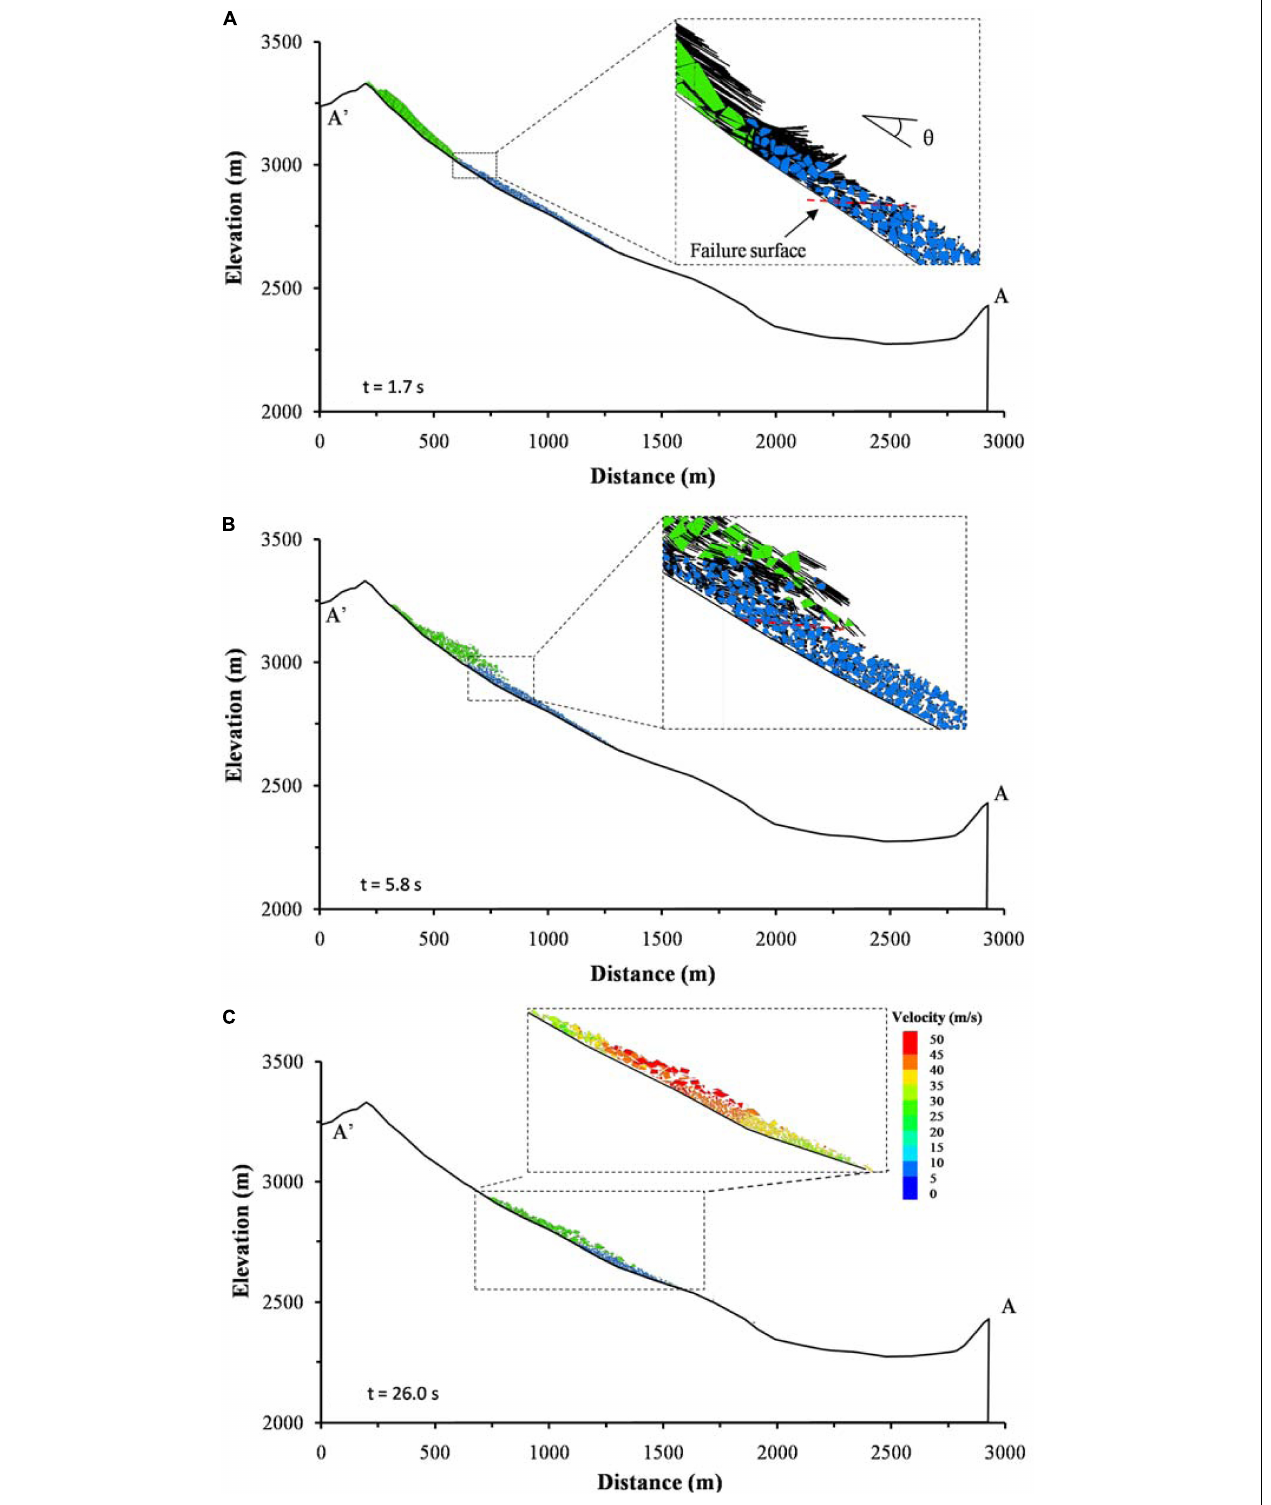
FIGURE 13 | Entrainment process at different times: (A) frontal plowing and substrate failure; (B) thickened substrate under compression; and (C) completely displaced colluvium indicated by the moving leading edge with a velocity more than 15 m/s. An interface (red dash line) between failed and static colluvium with an inclination angle ( θ ≈ 28 ◦ ) with respect to the base of the substrate under the plowing of the sliding mass can be seen at the beginning of the entrainment process.